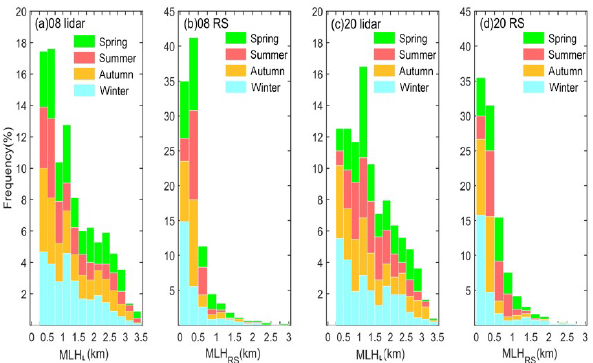
Figure 5. Comparison of the frequency distribution of all MLH L (2013–2018) retrieved from lidar and MLH RS from radiosonde with supplementary information on seasonal variation. The MLHs from (a) lidar and (b) radiosonde at 08:00 (LST) as well as (c) lidar and (d) radiosonde at 20:00 (LST) are presented. Noted that for present- ing the detailed distribution, MLH L adds up to 20%, while MLH RS adds up to 45%.